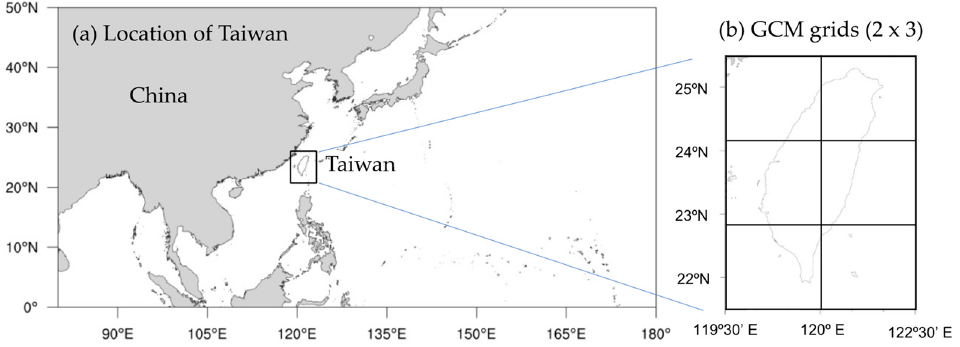
Figure 1. Evaluation area of GCM performance. ( a ) Location of Taiwan in east Asia; ( b ) Sketch diagram of 6 points over Taiwan in GCM which were adopted to calculate performance index.